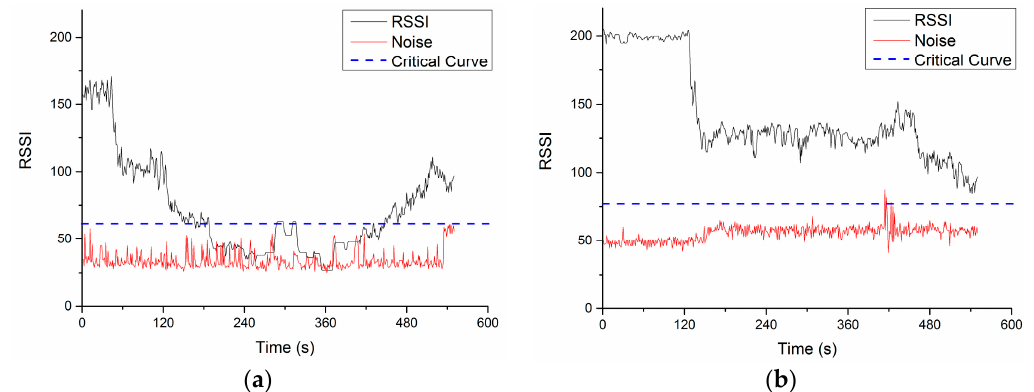
Figure 18. Received Signal Strength Indicator (RSSI), noise and critical curve of both ( a ) UAV “Son” and ( b ) UAV “Mom”.